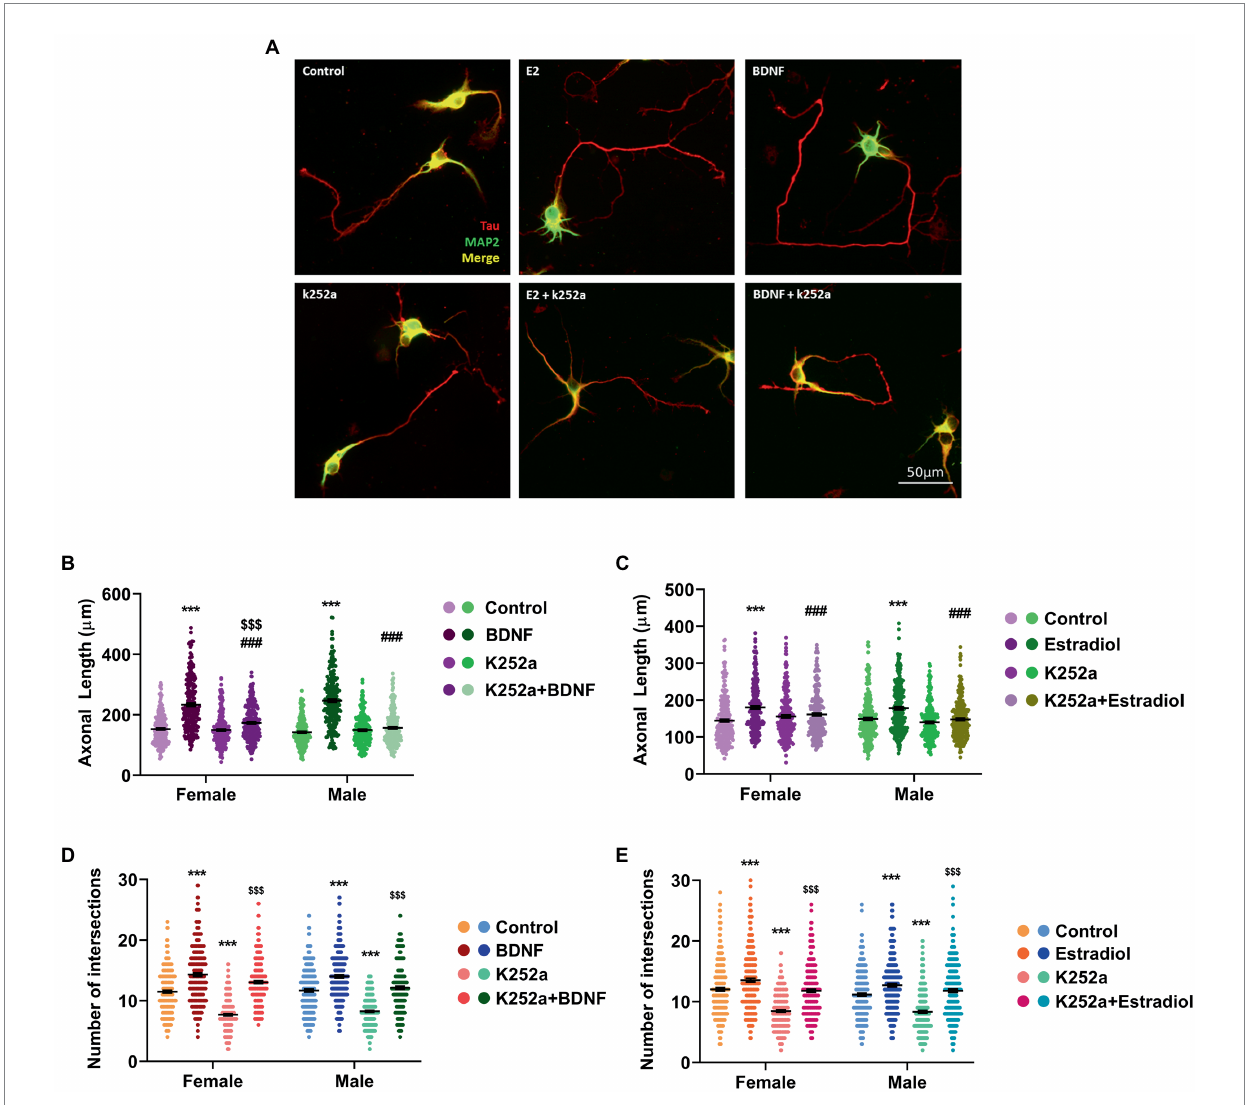
FIGURE 3 Implication of TrkB receptor in the actions of estradiol and BDNF on neuron morphology. (A) Representative example of neurons treated with E2, BDNF, k252a, and the combinations E2 + K252a, BDNF + K252a. Neurons are immunostained for MAP2 (green) and Tau (red). (B–E) Quantitative analysis of axonal length and complexity of the dendritic arbor (number of intersections of dendrites with the circles in the Sholl analysis) of sex-separated cultures treated with E2, BDNF, and K252a and the combinations E2 + K252a, BDNF + K252a. Neurons quantified (50–100) are at least from four independent experiments. Data represent the mean ± SEM; two-way ANOVA with Tukey’s multiple comparisons: *** p < 0.001 vs. control groups; ### p < 0.001 vs. BDNF or Estradiol treated groups; and $$$ p < 0.001 vs. K252a treated